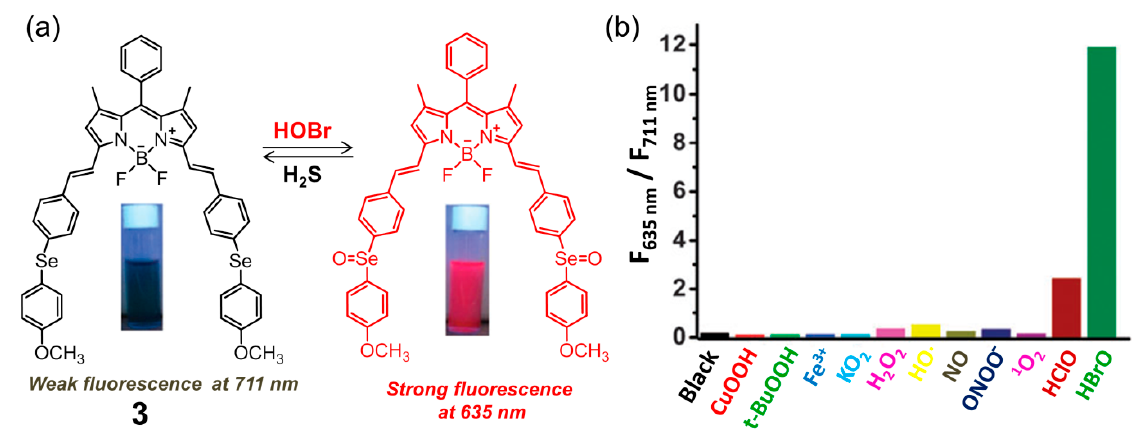
Figure 4. ( a ) Ratiometric fluorescent probe 3 on Se-BODIPY for selective recognition of HOBr followed by H 2 S in a redox cycle; ( b ) fluorescence intensity ratio (F 635 nm /F 711 nm ) of 3 upon reacting with various ROS for 60 min. Reproduced with permission from Reference [69]. Copyright 2013 Royal Society of Chemistry.